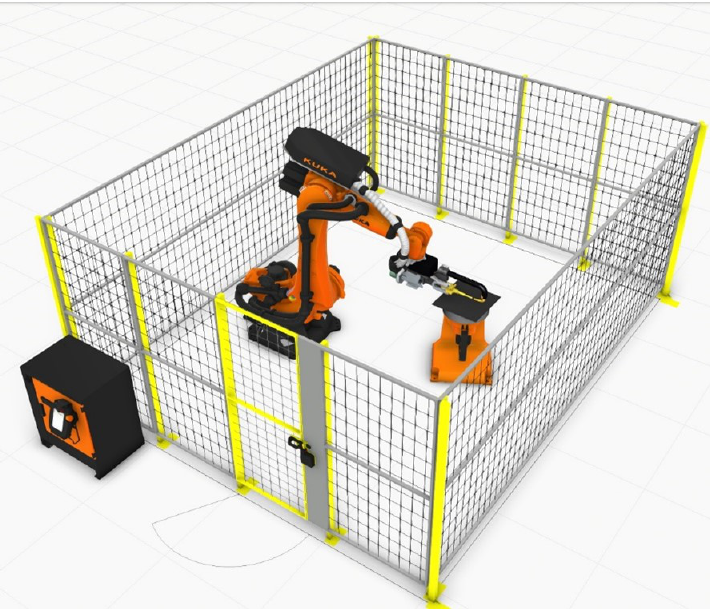
Figure 3. General view of test stand developed in KUKA.SIM